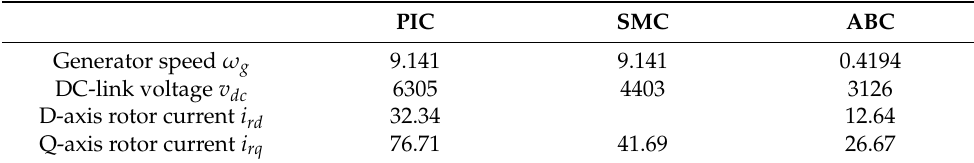
Table 2. ITAE of PIC, SMC, and ABC errors.